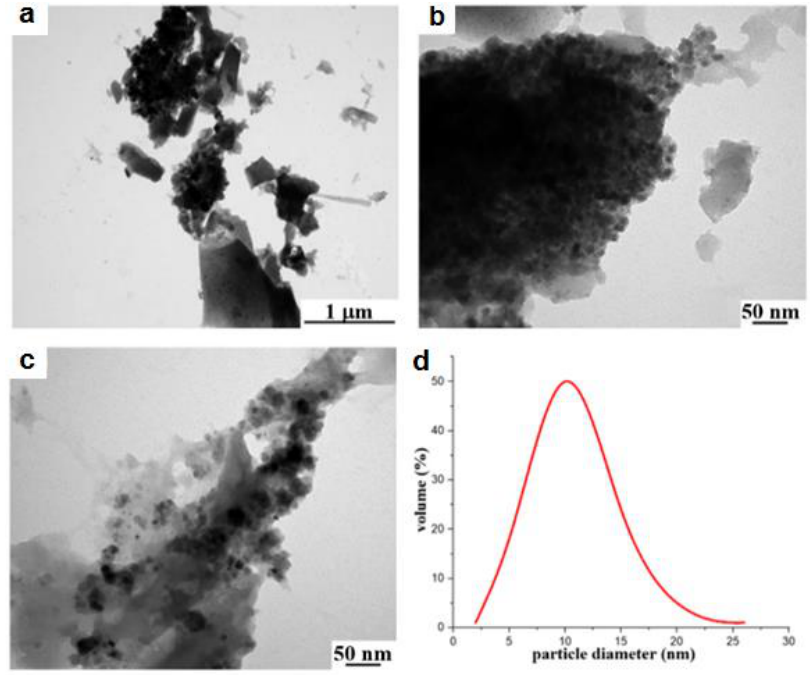
Figure 9. ( a – c ) TEM images and ( d ) particle size distribution curve of sample 2a .